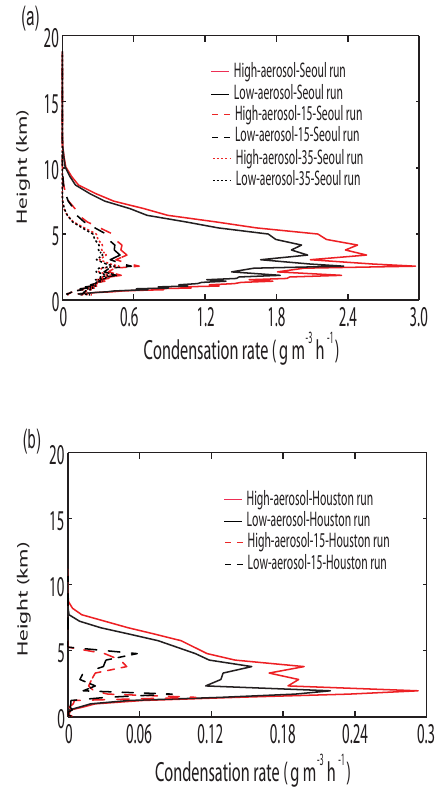
Figure 8. Vertical distributions of the time- and domain-averaged condensation rates for (a) the Seoul case and (b) the Houston case. Solid lines represent simulations at the 500m resolution, while dashed lines represent those at the 15km resolution. Dotted lines represent simulations at the 35km